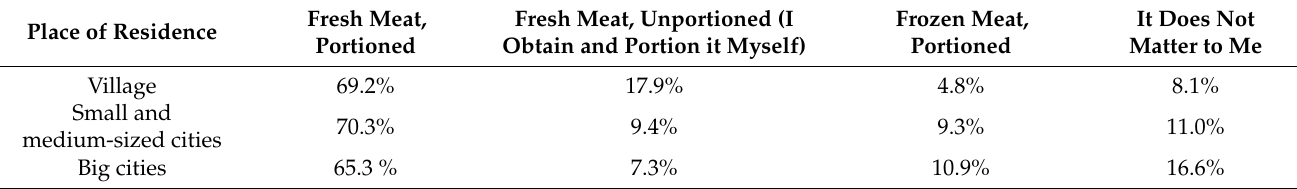
Table 8. When buying meat-game, you prefer ( n = 433).